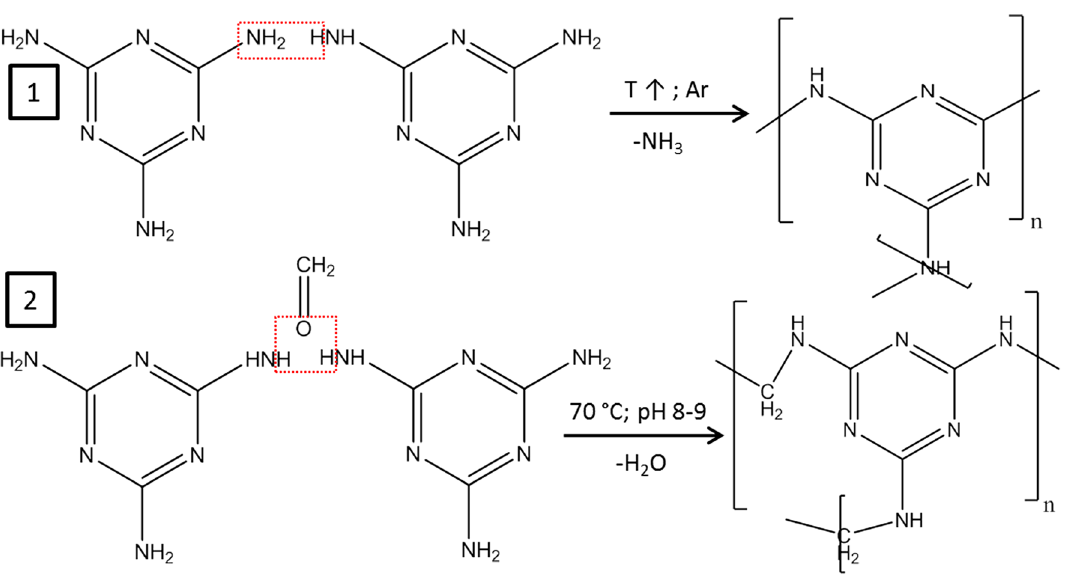
Fig. 1 Synthesis scheme of nitrogen-containing polymers on the surface of CNTs. 1 Polymerization of melamine (CNT-M), 2 synthesis of a melamine–formaldehyde resin